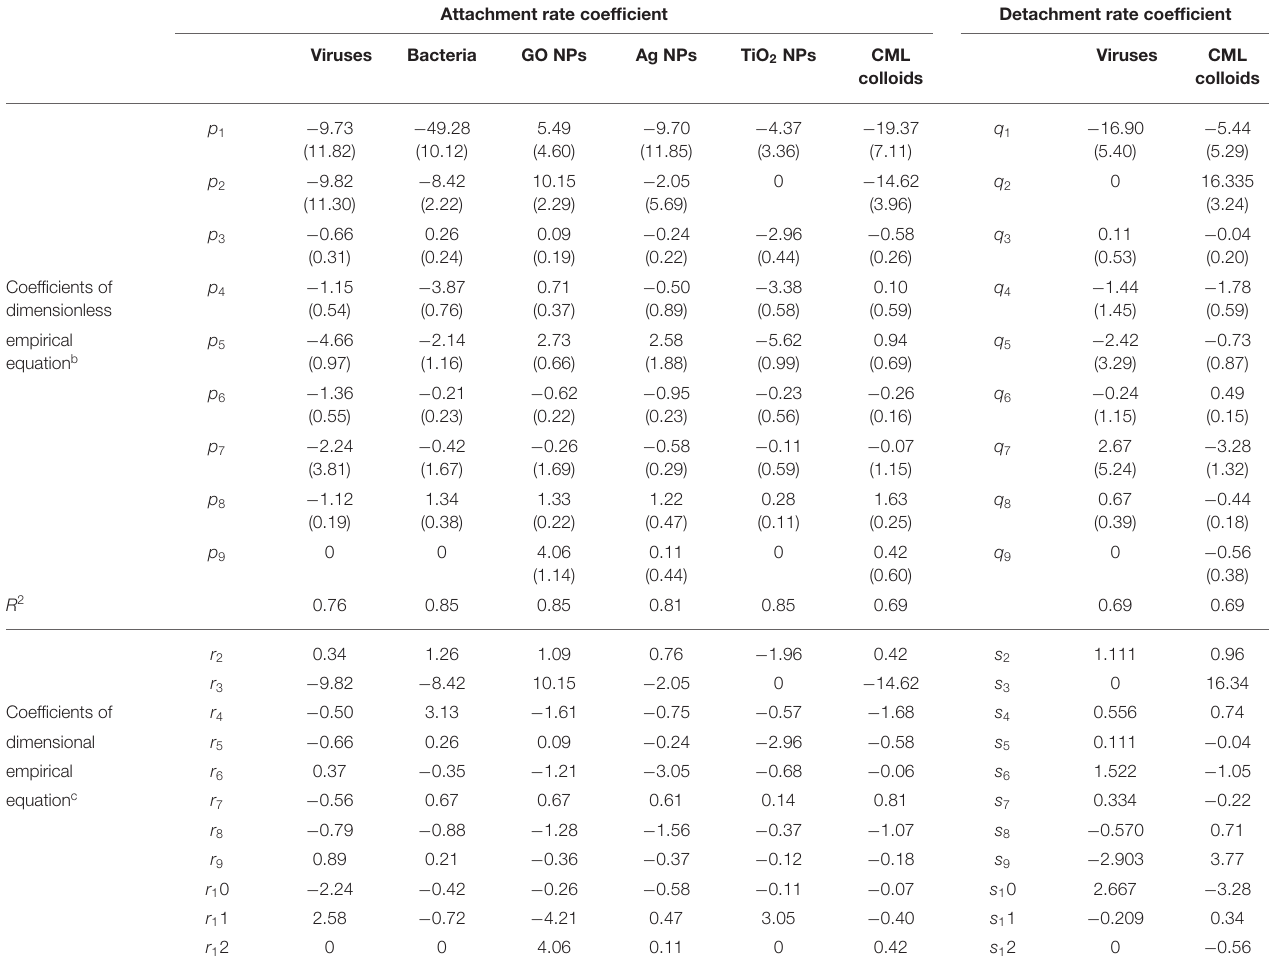
TABLE 8 | Estimated values of coefficients in the empirical equations for the deposition rate coefficients of various colloids a